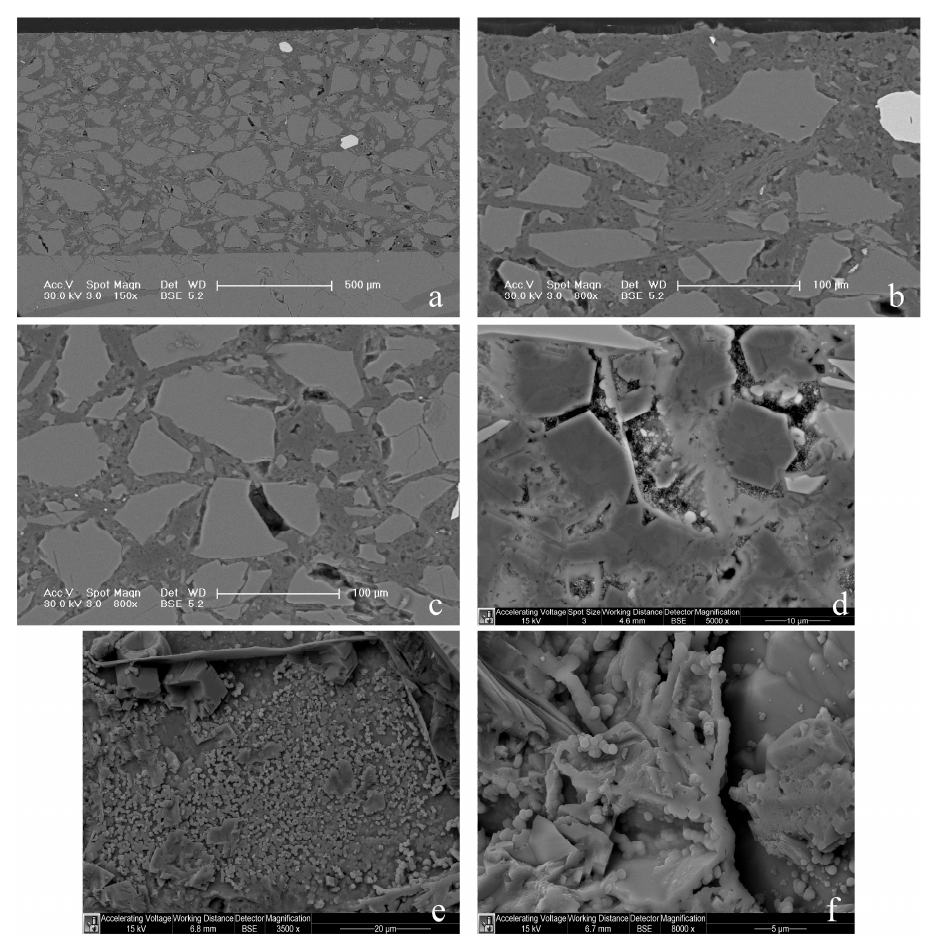
Figure 8. ( a , b ) SEM BSE micrographs of a polished section through the reacted powder layer of sample